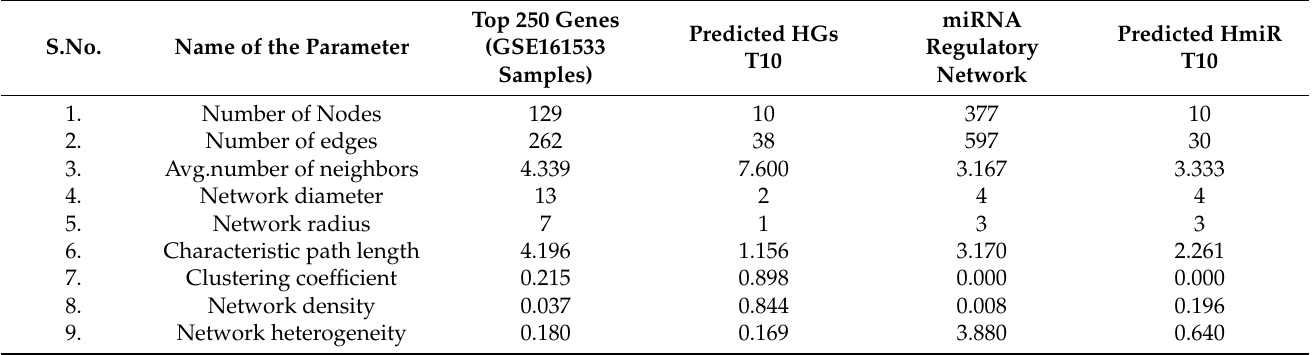
Table 1. The network parameter for the constructed PPI network for the top 250 genes, predicted HGsT10, miRNA-HGsT10, predicted HmiRT10 were analyzed using the Network Analyzer plugin and tabulated.